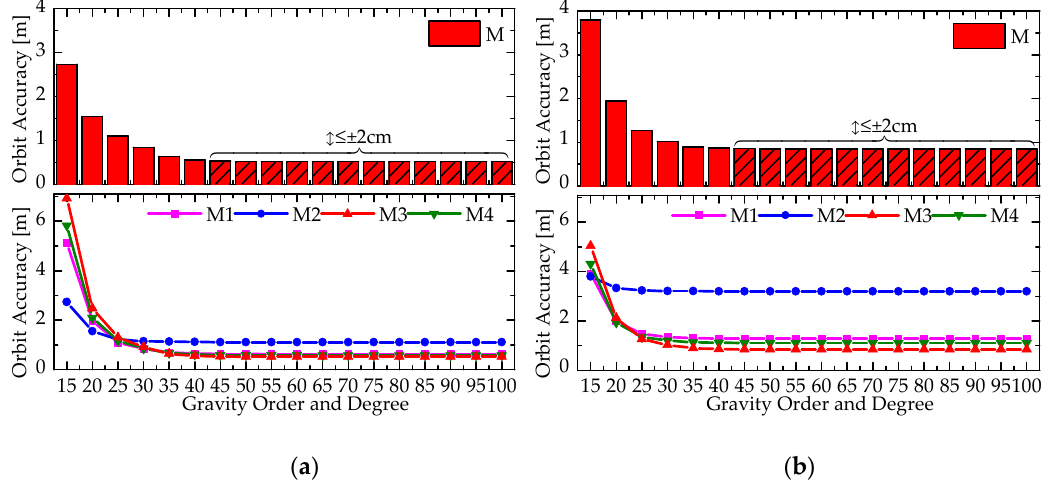
Figure 4. Comparison of real-time orbit accuracies of the FY3C satellite under different order/degree of truncated gravity models (15×15~100×100) and different stochastic parameters setting (M1: τ = 1 s, σ 2 = 1 × 10 − 14 m 2 /s 5 ; M2: τ = 30 s, σ 2 = 1 × 10 − 16 m 2 /s 5 ; M3: τ = 60 s, σ 2 = 1 × 10 − 18 m 2 /s 5 ; M4: τ = 900 s, σ 2 = 1 × 10 − 20 m 2 /s 5 ): ( a ) The position accuracy of the carrier-phase-based solution; ( b ) The position accuracy of the pseudo-range-based solution.